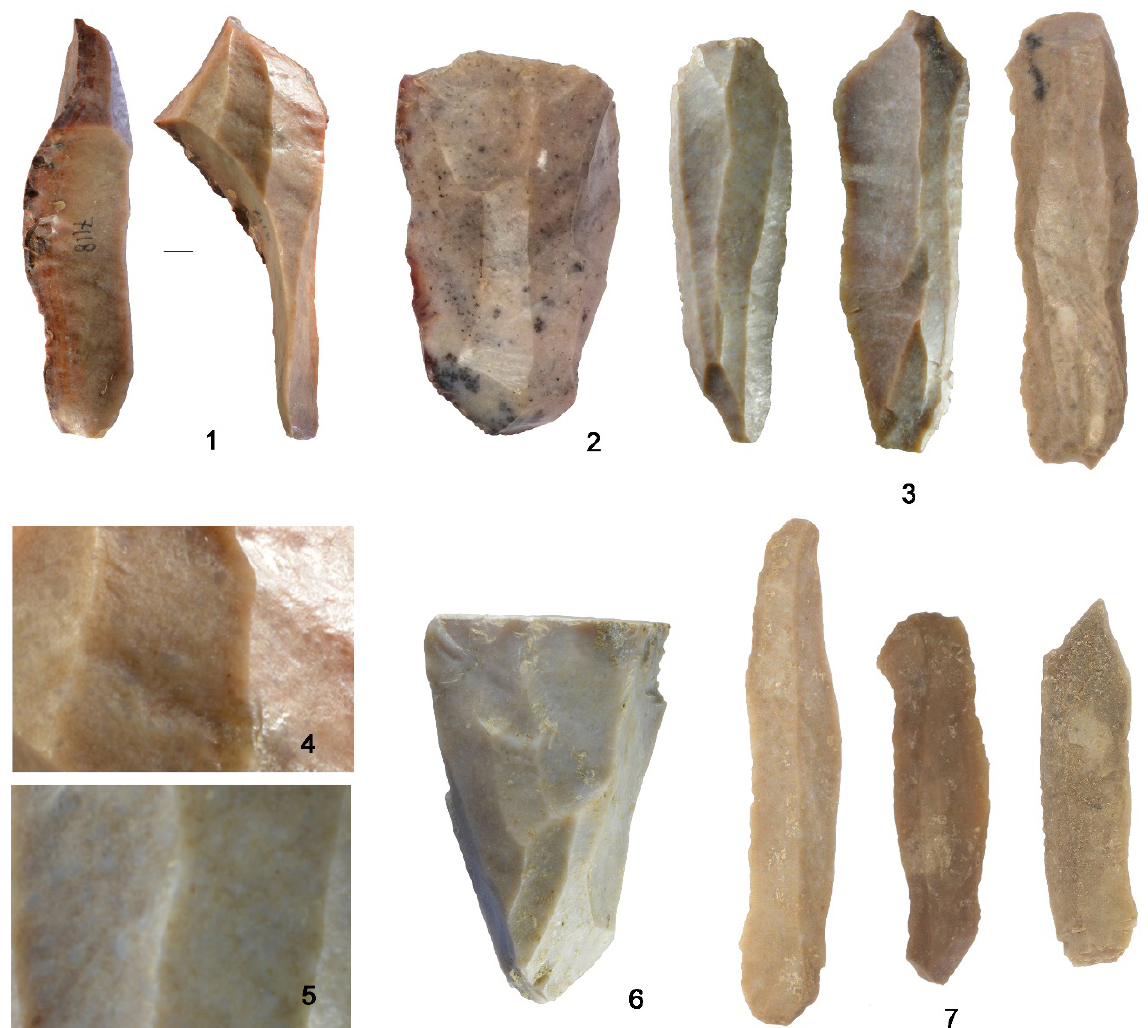
Figure 3. Flint artefacts recovered from Hasankeyf Höyük. 1-3: Heat-treated flint. 4, 5: Close-up view of the flaked surface after heat treatment. 6, 7: Unheated flint (1: Overshot blade; 2, 6: Core; 3, 7: